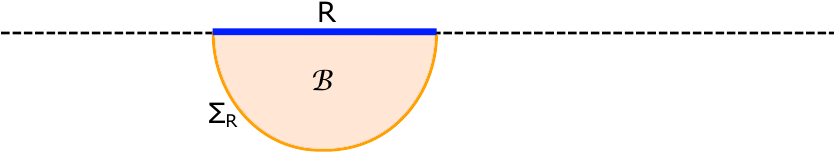
Figure 18. The subregion complexity of the boundary subregion R is given by the volume of the maximal bulk codimension one surface B anchored at R and its HRT surface Σ R . The maximization is done over the time